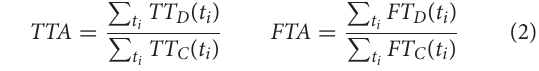
t i , both for coincidence and disparity neurons. Spikes